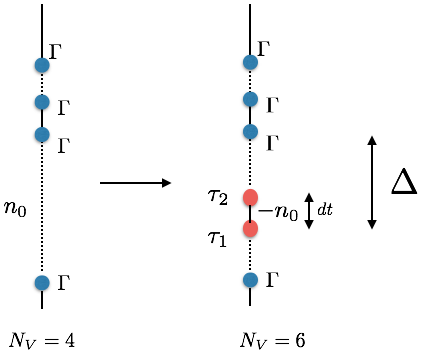
Figure 3: Illustration of the INSERT / REMOVE pair of updates for the two-level